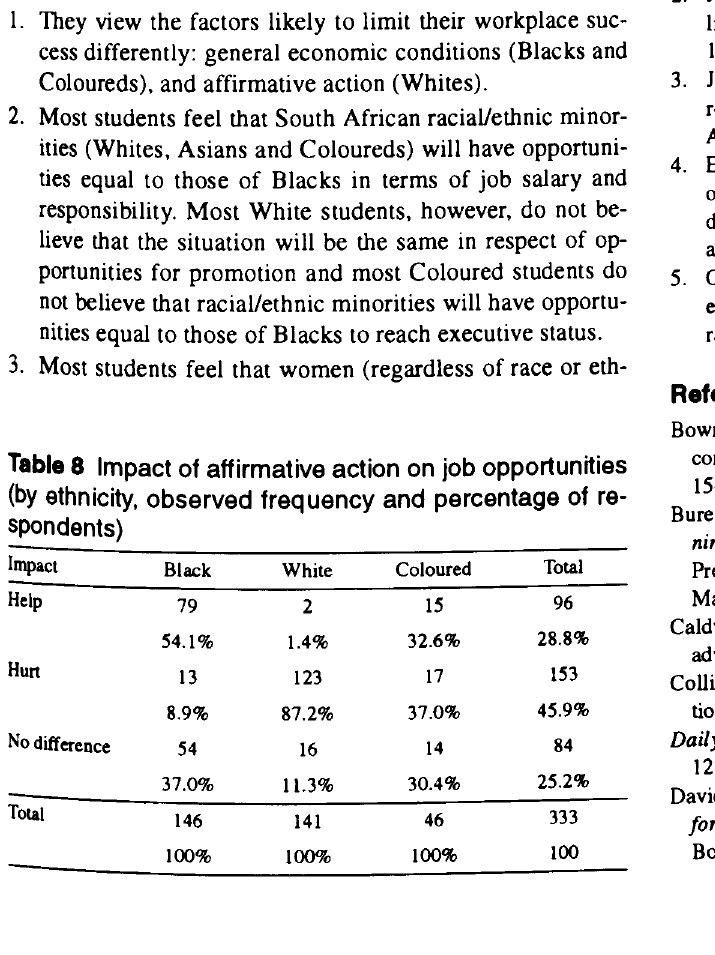
Table 8 Impact of affirmative action on job opportunities (by ethnicity, observed frequency and percentage of